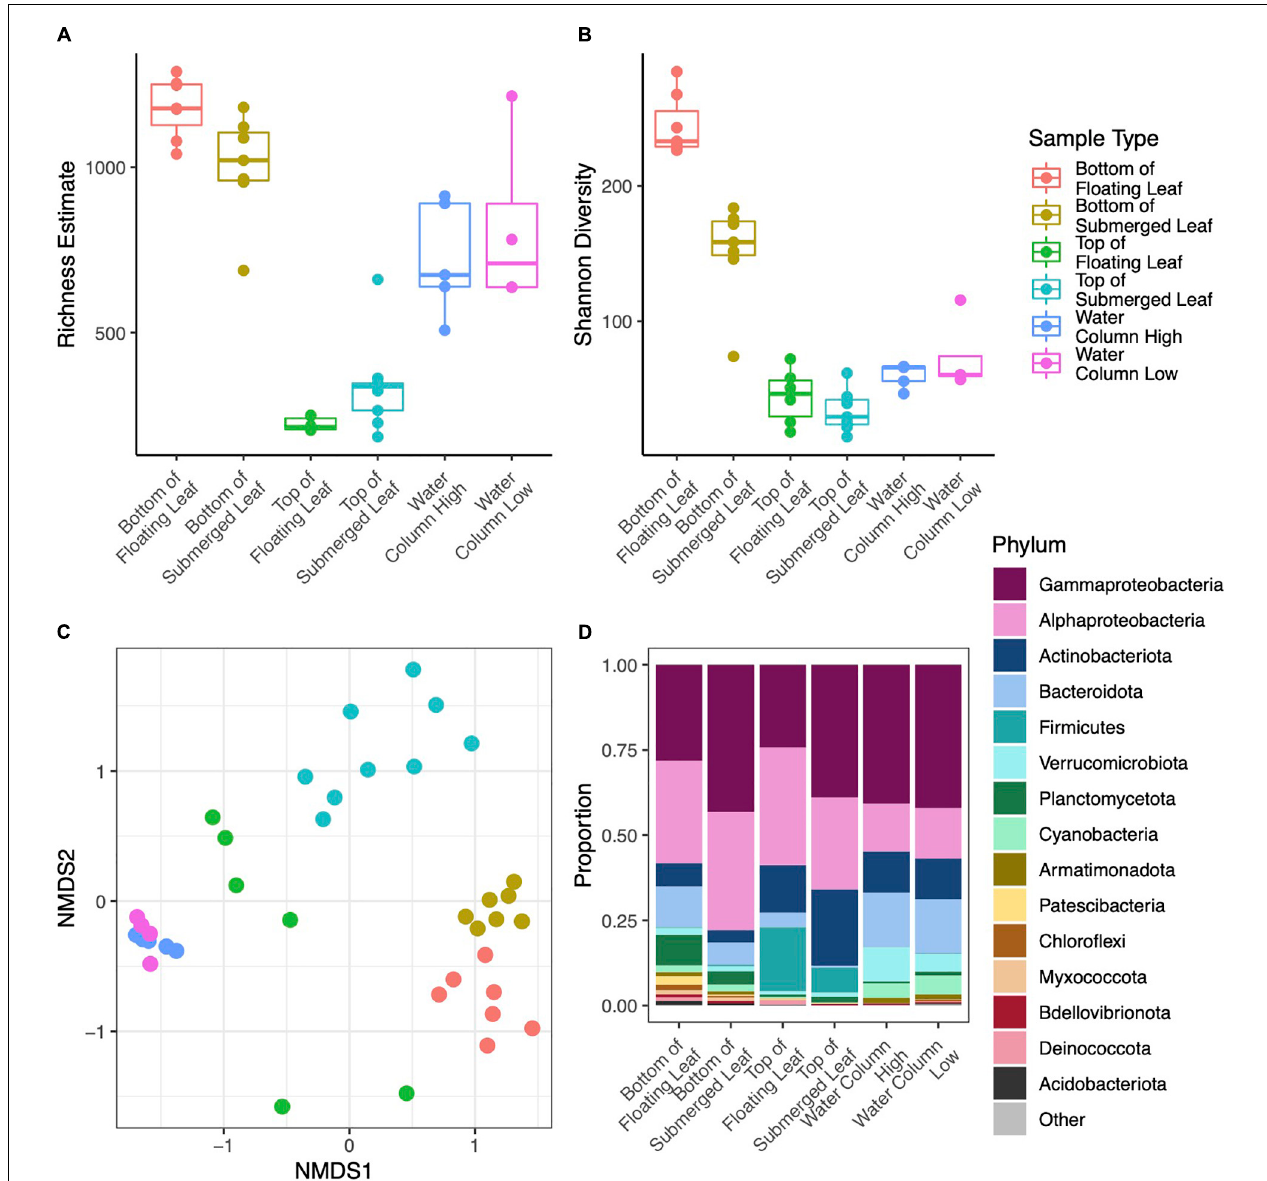
FIGURE 5 | Point estimates for microbial richness estimated with Breakaway (A) , Shannon Diversity (B) , NMDS ordination of Bray-Curtis dissimilarities (colors correspond to the legend shown in the top row) (C) , and Phylum level taxonomic composition (D) for microbial samples collected from leaf surface and the water column within Long Lake. Panel (D) only includes phyla with mean relative abundance greater than 0.1% across all samples and the phylum Proteobacteria has been broken down by